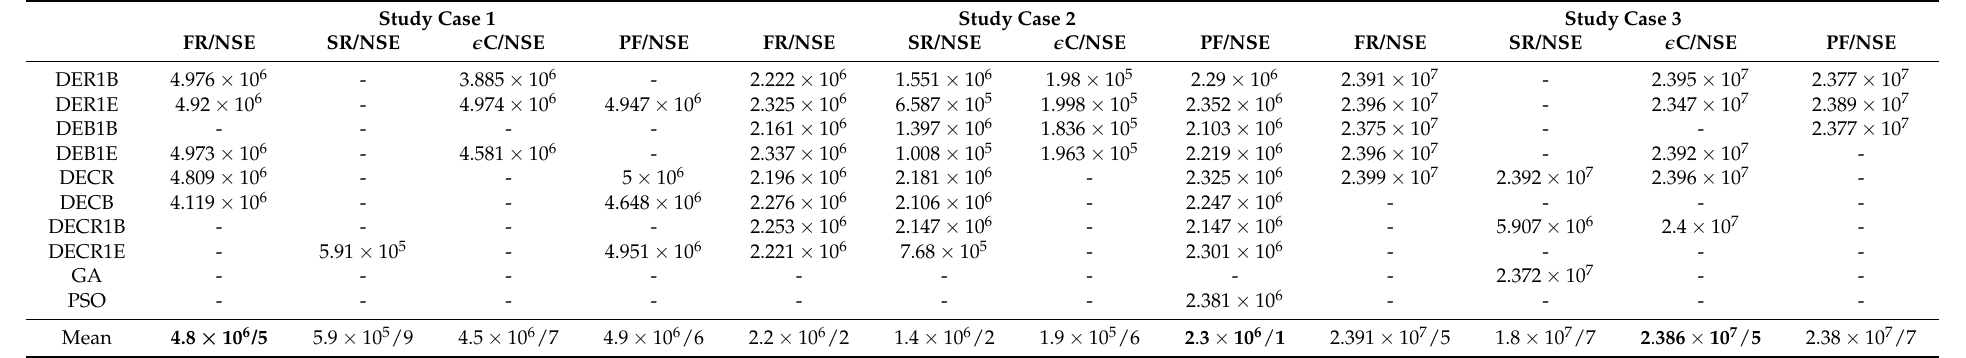
Table A14. AFES metric values for each algorithm with the CHTs, and the related average values per CHTs for three study cases. Non-Successful Executions (NSE) is represented as ’-’.